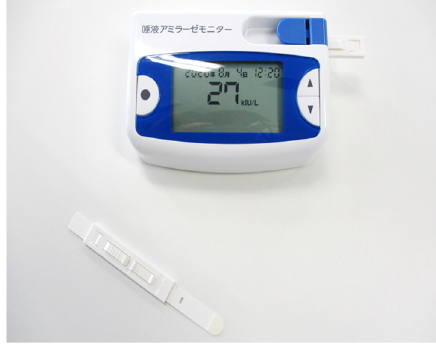
Figure 5. Salivary amylase activity monitor (for Japanese).